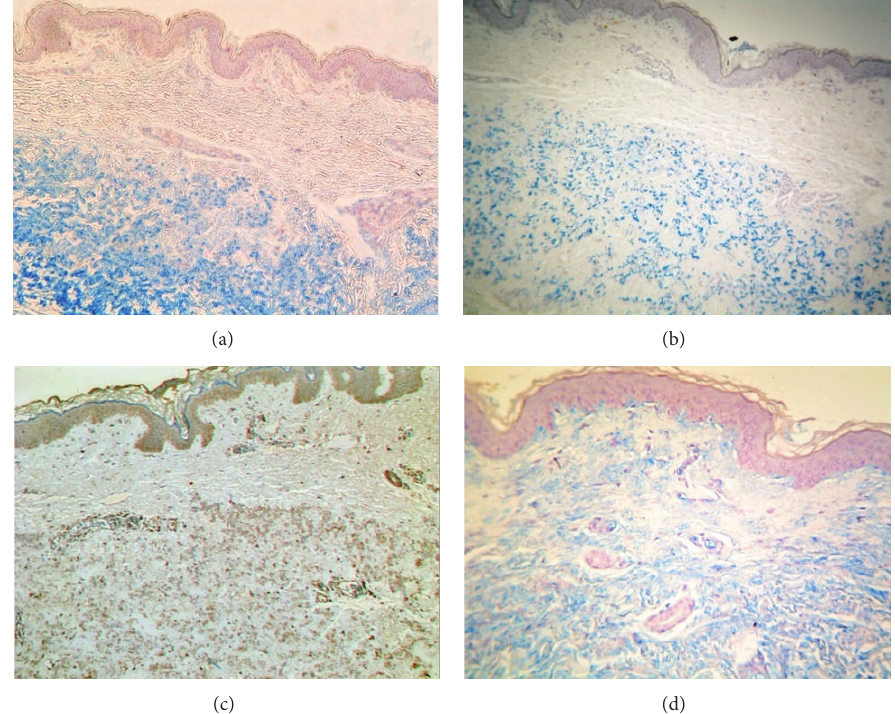
F 5: Immunohistochemical �ndings in PXE, showing excessive middermal staining of carboxylated (a,